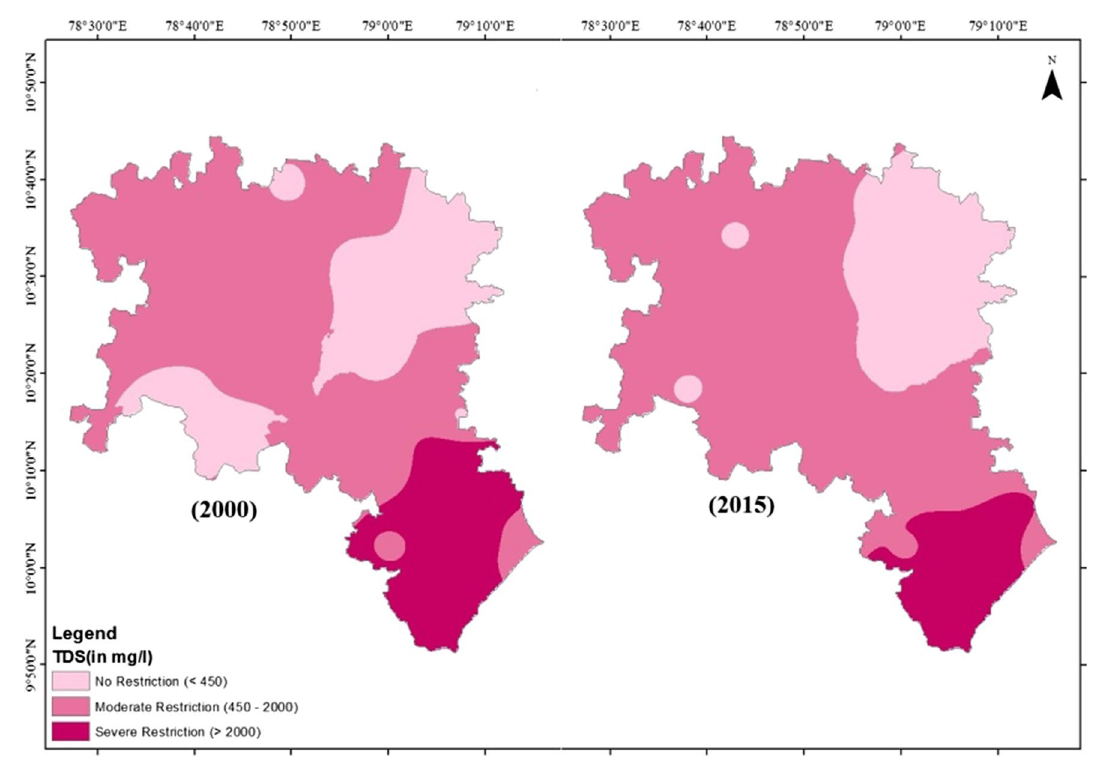
Fig. 4 Spatial distribution of TDS (2000 and